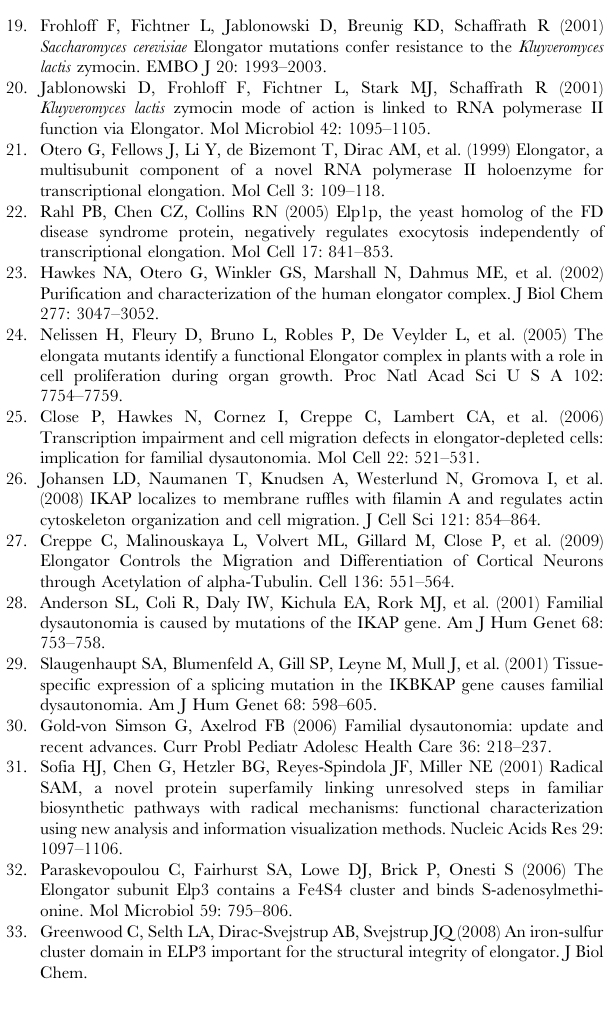
to aldicarb. The proportion of worms still able to move is plotted against time. 25–30 worms were used for each genotype. The assay was performed blind in triplicate at room temperature ( ca. 21.5 u C). The worms were cultivated at 25 u C prior to being assayed. Found at: doi:10.1371/journal.pgen.1000561.s009 (0.66 MB TIF) Figure S10 Defects Seen in Temperature-shifted elpc-3 ; tuc-1 Double Mutants. Micrographs of eggs and larvae viewed with Nomarski DIC optics. (A–D) Embryos arrested prior to (A), during (B,C) or after (D) morphogenesis. (E,F,G,H) Parts of the germline in young adult hermaphrodites. The arrows in E and F indicate oocytes. Note that those in the elpc-3; tuc-1 worm have not matured. The arrows in G and H denote sperm. Those in the elpc- 3 ; tuc-1 worm have grossly abnormal morphology. (I,J) The descendants of P5.p, P6.p and P7.p during the L4 stage. The arrows in I denote the descendants of P5.p, P6.p and P7.p. In the animal shown, these three cells adopted the 3 u cell fate and divided just once. In wild-type worms, P6.p adopts the 1 u cell fate whereas P5.p and P7.p adopt the 2 u fate. The 1 u and 2 u fates involve three rounds of cell division; the descendants of P5.p, P6.p and P7.p together form a tube through which the eggs are laid. The arrow in J denotes the tube as it is forming. Scale bars denote 10 microns. Found at: doi:10.1371/journal.pgen.1000561.s010 (2.42 MB TIF)